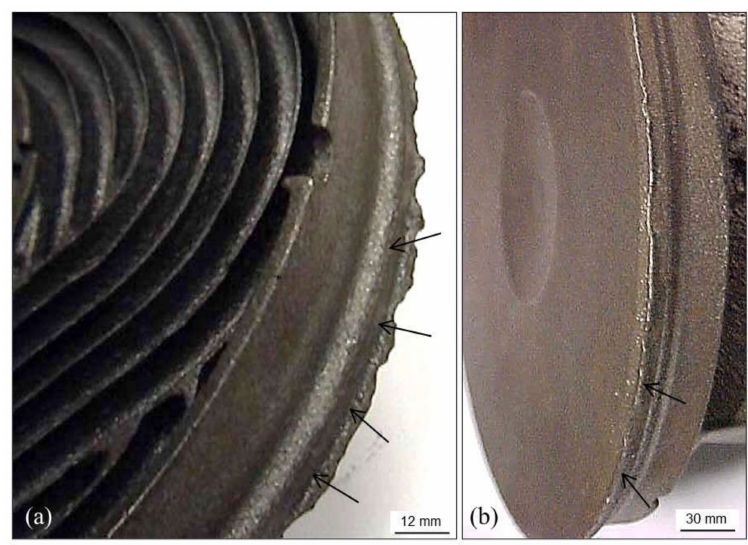
Figure 46. ( a , b ) swelling defect in a grey iron cook